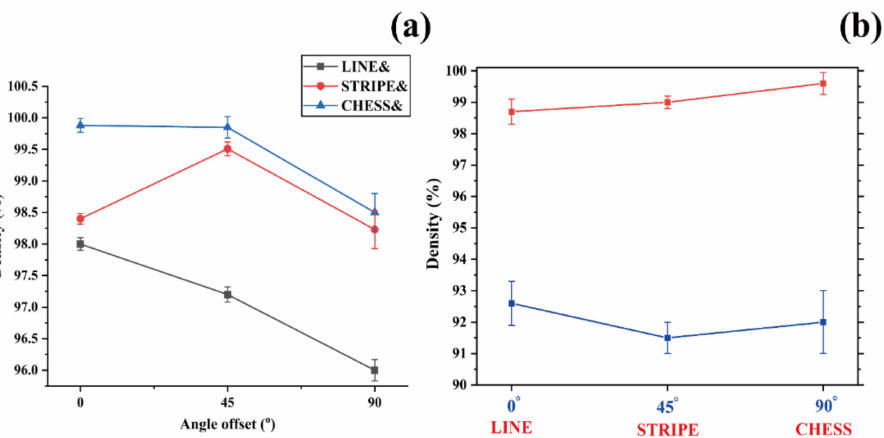
Figure 11. The density of L-PBF samples under different combinations of scanning strategies and a single scanning strategy. ( a ) The density of L-PBF samples under various combinations of scanning strategies; ( b ) the density of samples under angular offset scanning and general scanning